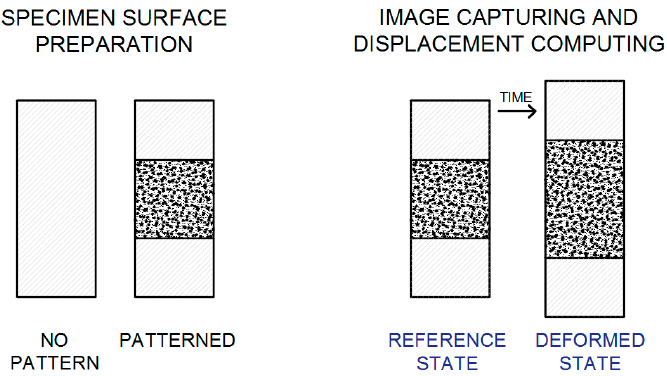
Figure 1. DIC method—Stages [17]. (The Creative Commons Attribution (CC BY 4.0) license (http: // creativecommons.org / licenses / by / 4.0 /